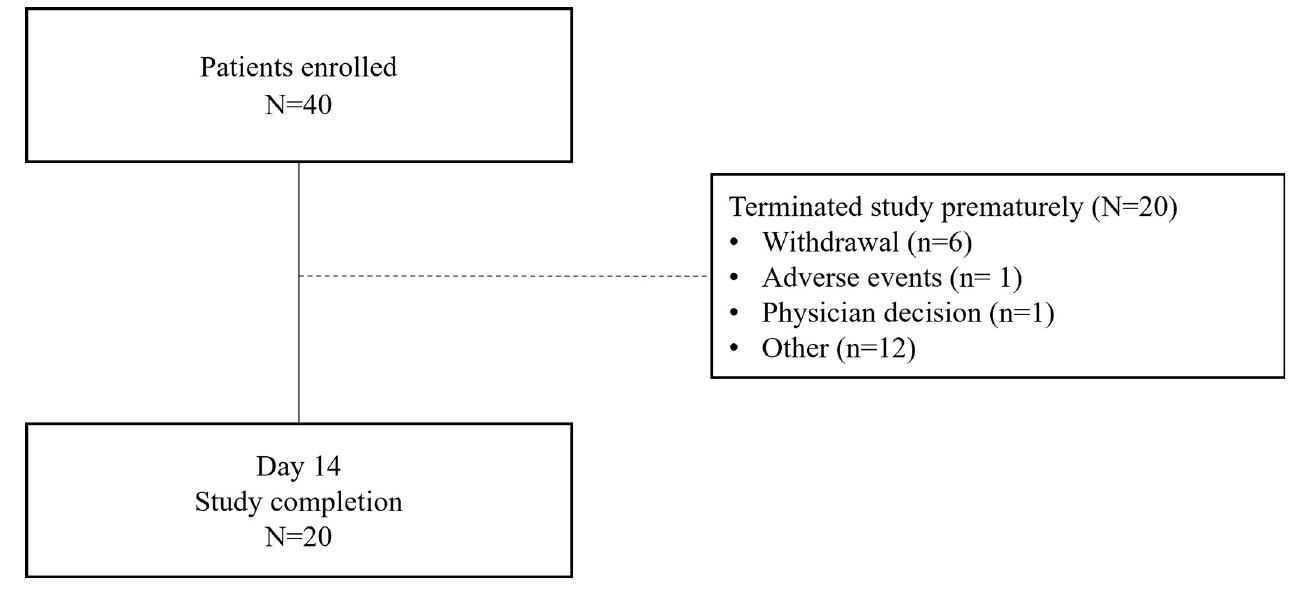
Fig 1. Participant